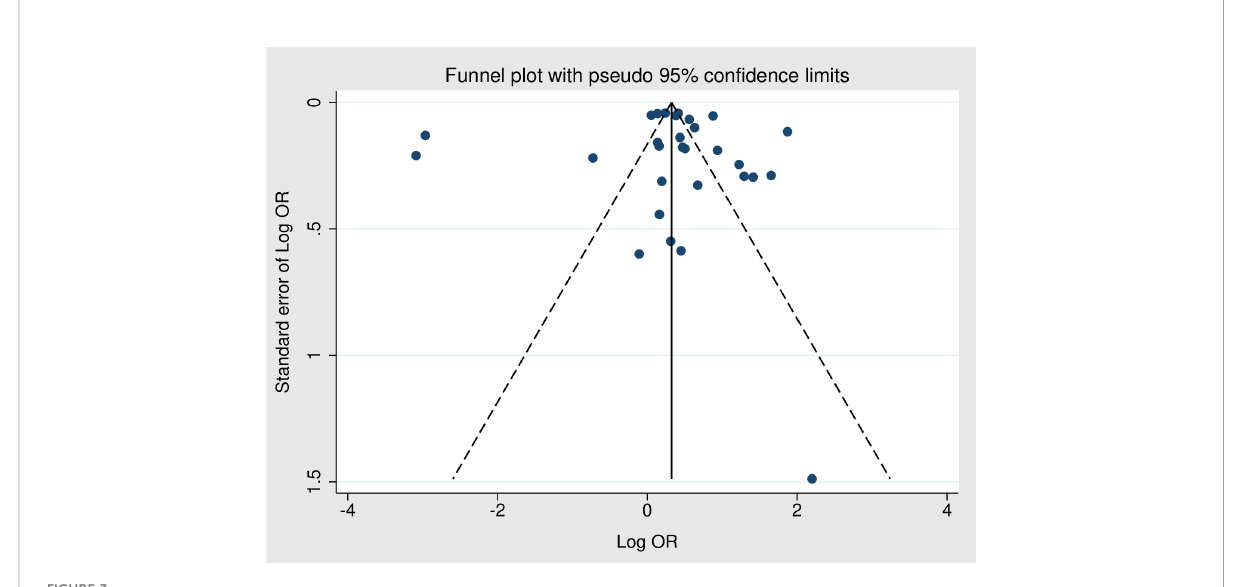
FIGURE 3 Funnel plot for the risk of periodontitis for obesity group compared to non-obesity group.